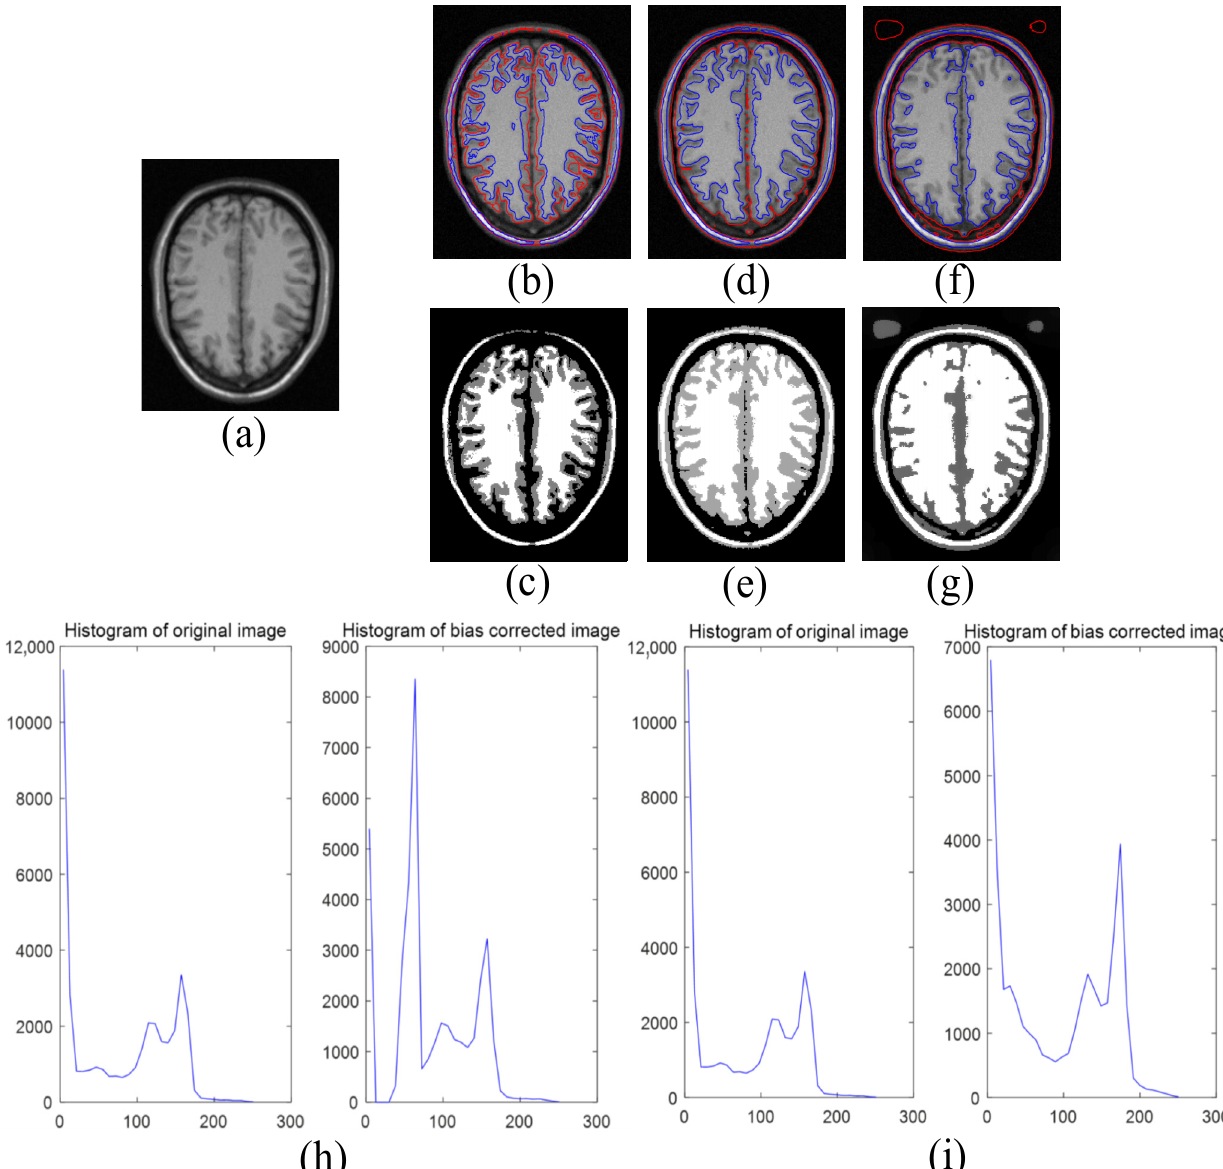
Figure 9. Performance of multiphase level set function and compared with the LIC model and the ALFB model. ( a ) Original image; ( b ) the results of our model; ( c ) the ground truth of our model; ( d ) the result of LIC model; ( e ) the ground truth of LIC model; ( f ) the result of ALFB model; ( g ) the ground truth of ALFB model; ( h ) the histogram of the original image and our model; and ( i ) the histogram of the original image and LIC model.